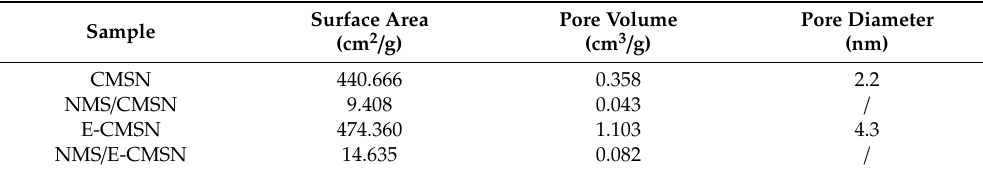
Table 1. Detailed textural parameters by N 2 adsorption measurements.